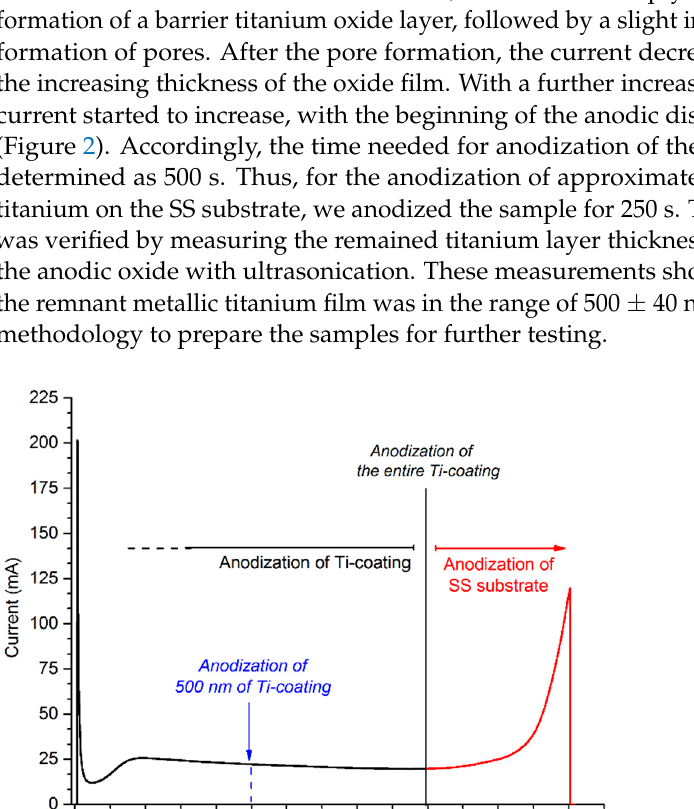
Figure 1. Surface preparation steps: #1 titanium coating on stainless ‐ steel, #2 anodization of tita ‐ nium, #3 ultrasonication of nanoporous TiO 2 , and #4 O 2 ‐ plasma treatment of cTi .